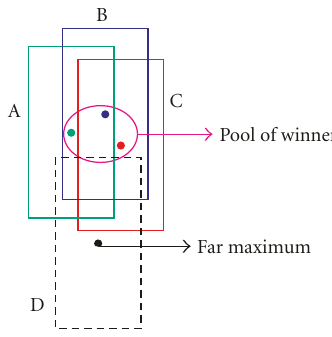
Figure 7: The bounding boxes are centered at the maxima. The union of the corners inside the bounding boxes A, B, and C are taken into